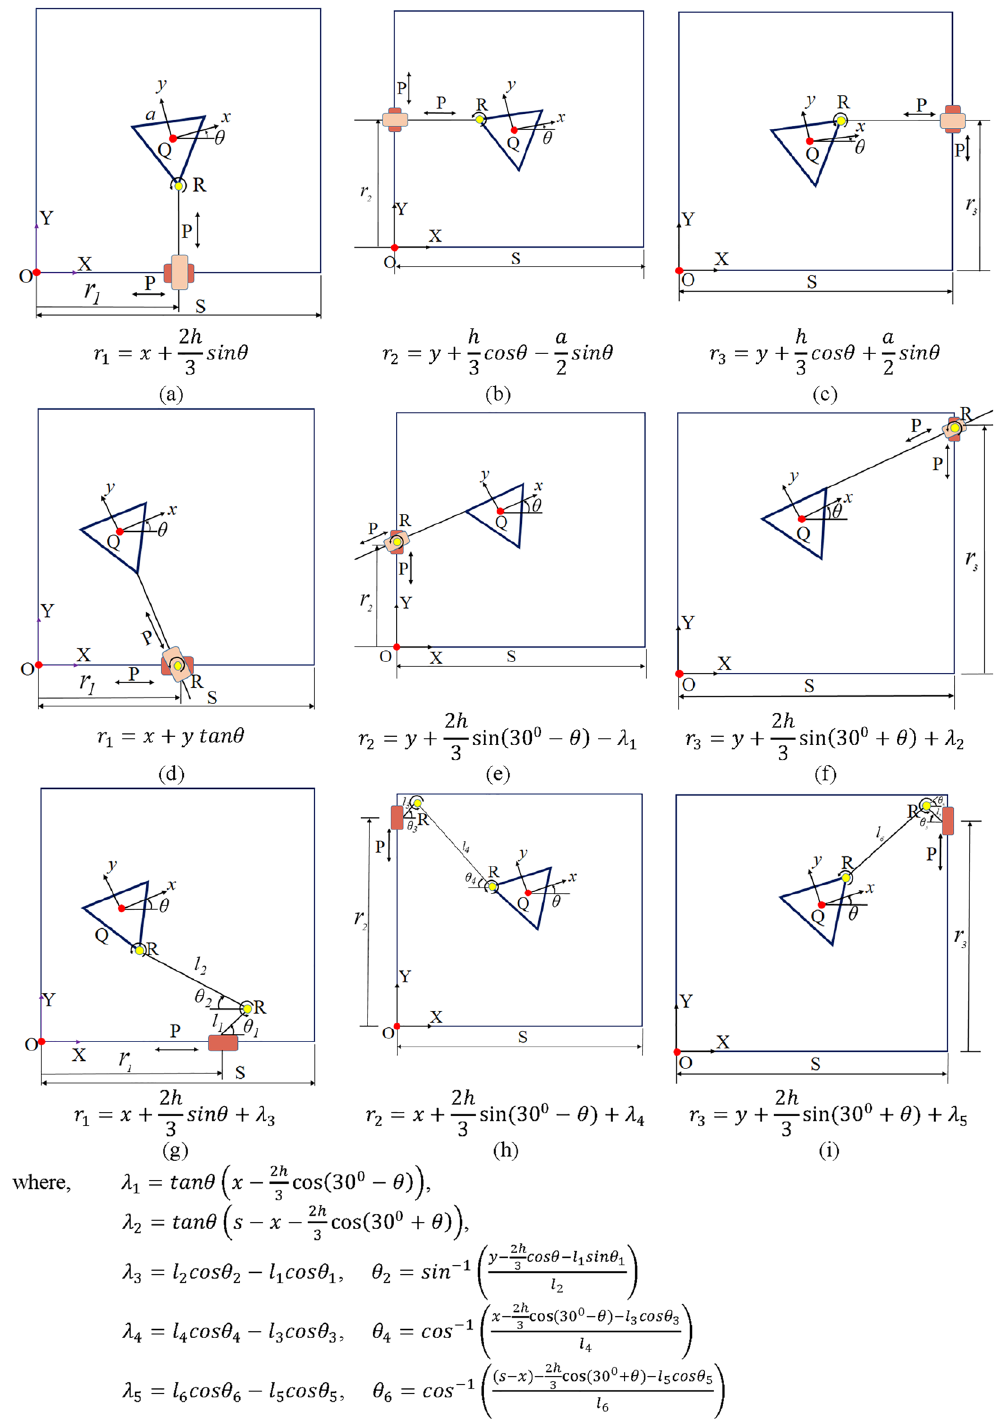
Fig. 3 Frame diagrams of the family of U-shape fixed-base planar parallel